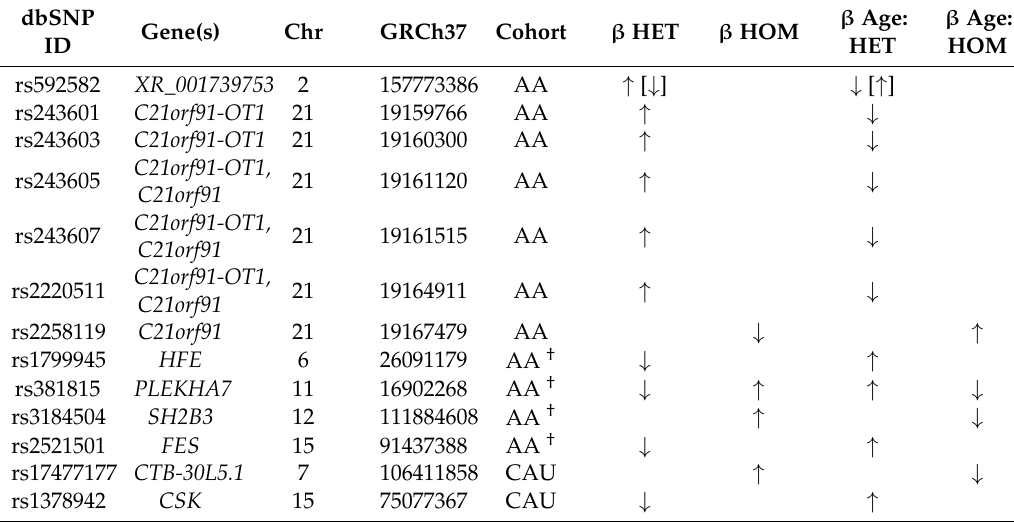
The Single Nucleotide Polymorphism Database identifier (dbSNP ID) from the National Center for Biotechnology Information, associated gene, chromosome (chr), position in GRCh37, and the HTN ancestral group of SNP